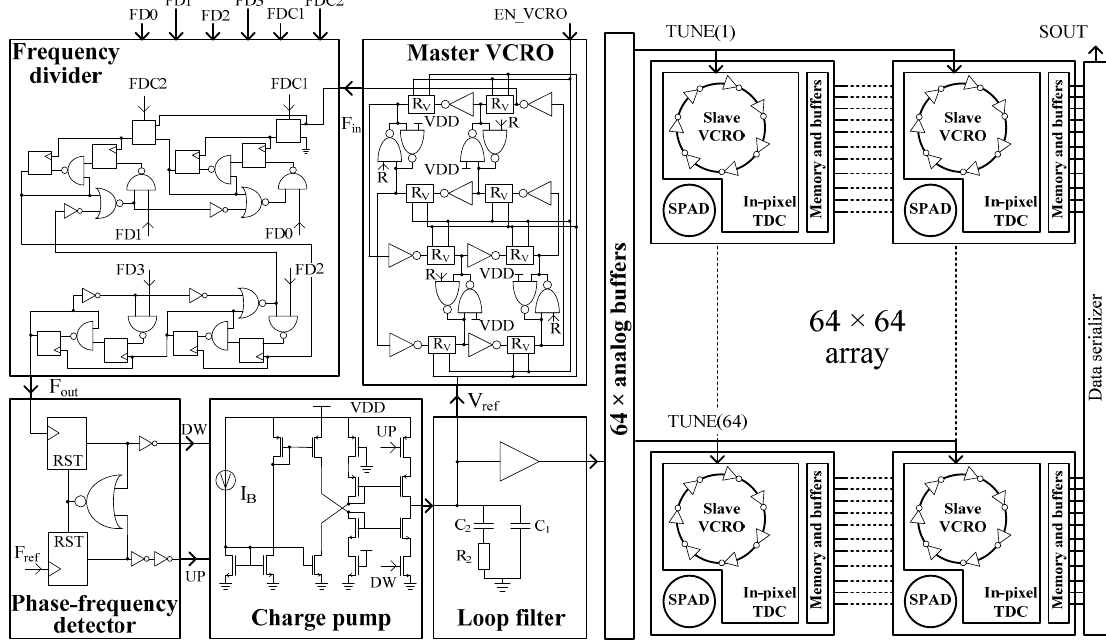
Figure 2. Compensation block diagram of global PVT variations.